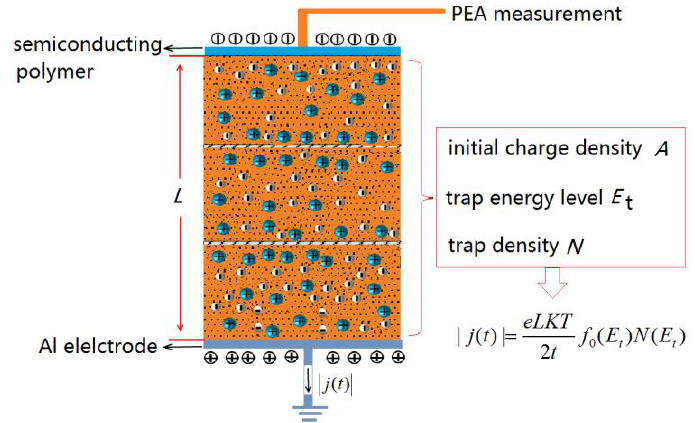
Figure 6. Trap distribution calculation based on the charge decay process.